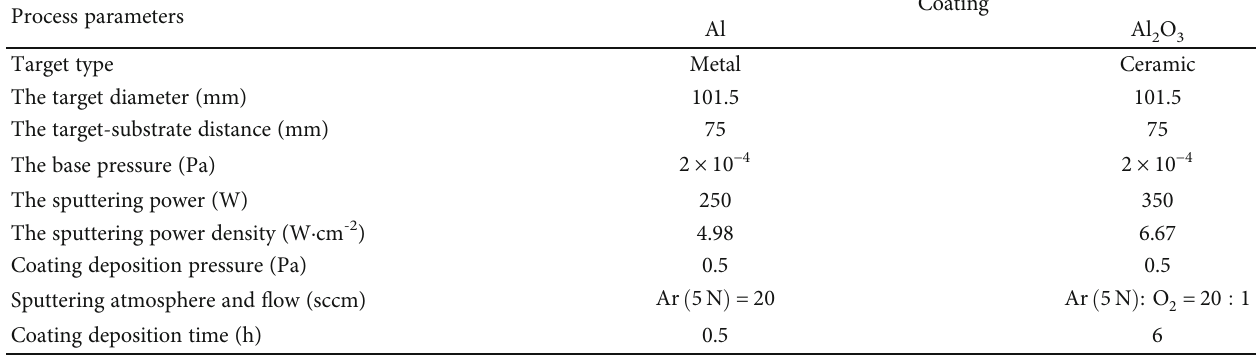
Table 1: The speci fi c process parameters of coating preparation by radio-frequency magnetron sputtering.